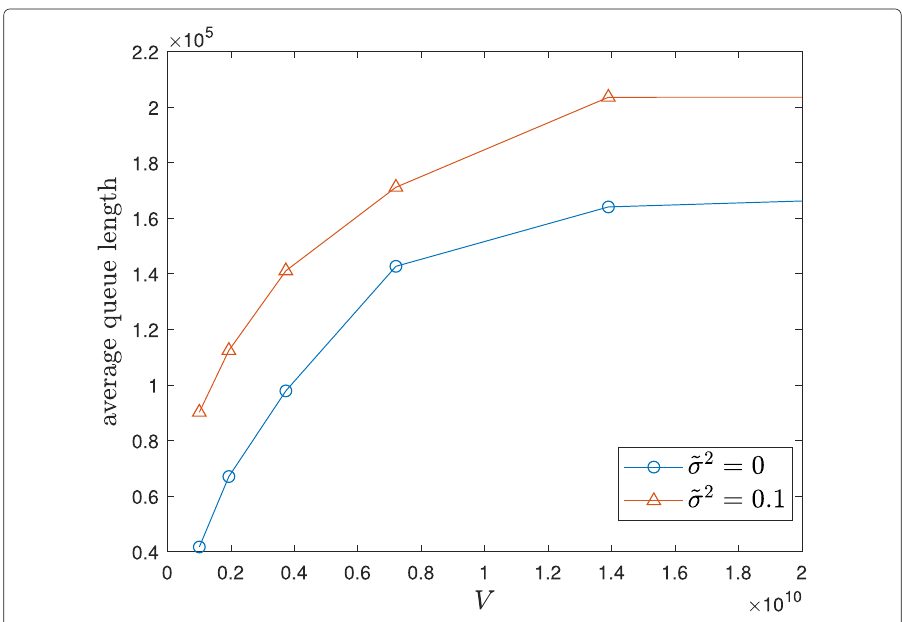
Fig. 4 The time-averaged queue length versus control parameter V